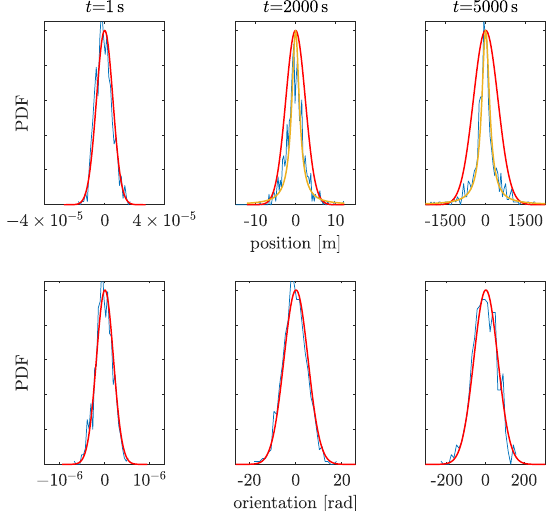
Figure 8. Same as Figure 7 for the low-frequency